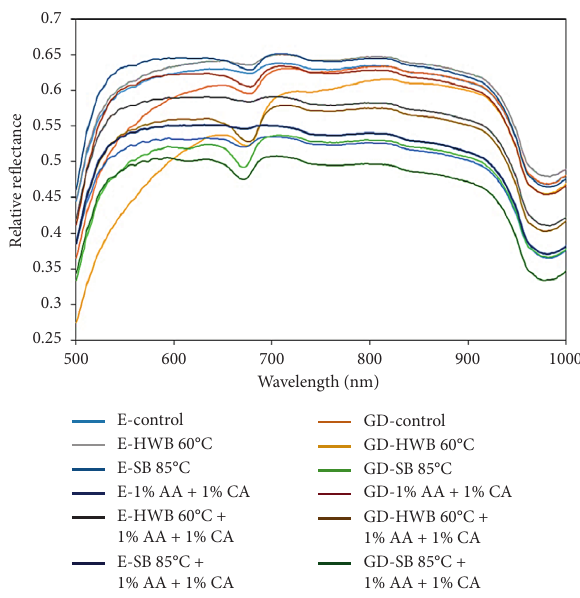
Figure 3: Spectral profile of apple